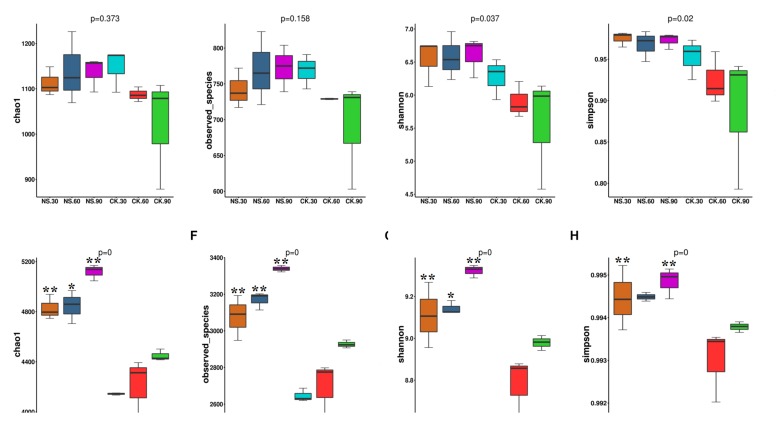
The community richness and diversity indexes of the fungal community (A–D) and bacterial community (E–H) in both rhizosphere soil and no-plant soil evaluated by MiSeq sequencing. NS30, NS60, and NS90 indicate rhizosphere soil from sanqi grown for 30, 60, and 90 days, respectively; CK30, CK60 and CK90 indicate no-plant soil collected at 30, 60, and 90 days, respectively. The values represent the means ± SE. An asterisk (∗) indicates that the differences between sanqi and its corresponding control treatment at the same time were significant at p < 0.05. An asterisk (∗∗) indicates that the differences were significant at p < 0.01.